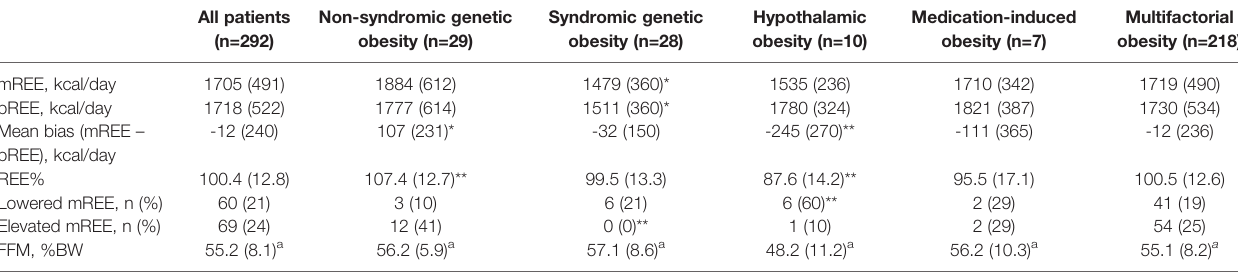
TABLE 3 | REE and body composition characteristics of the study